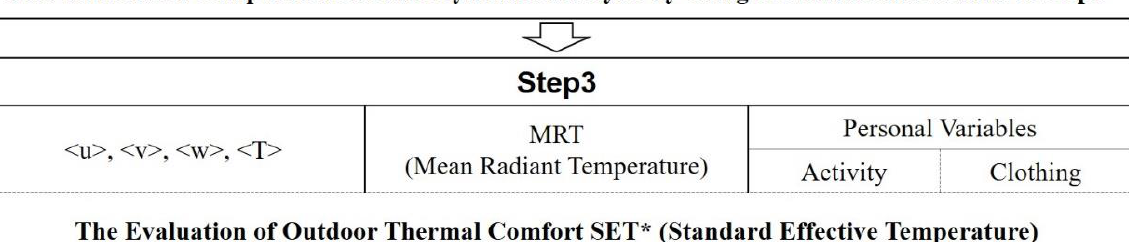
Figure 2. The flowchart of the prediction method for the outdoor thermal environment.